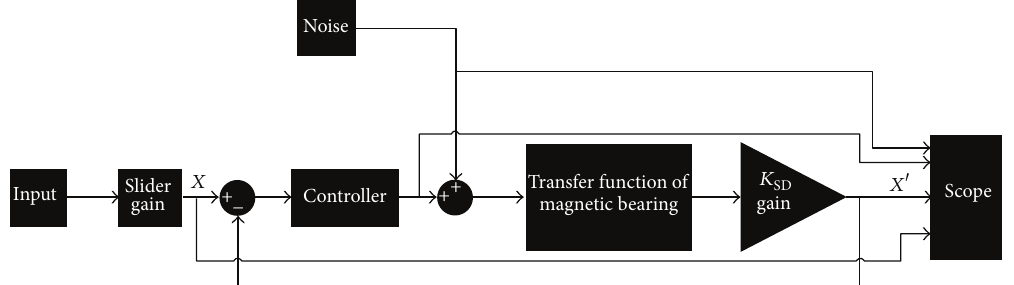
Figure 2: Block diagram of the system.